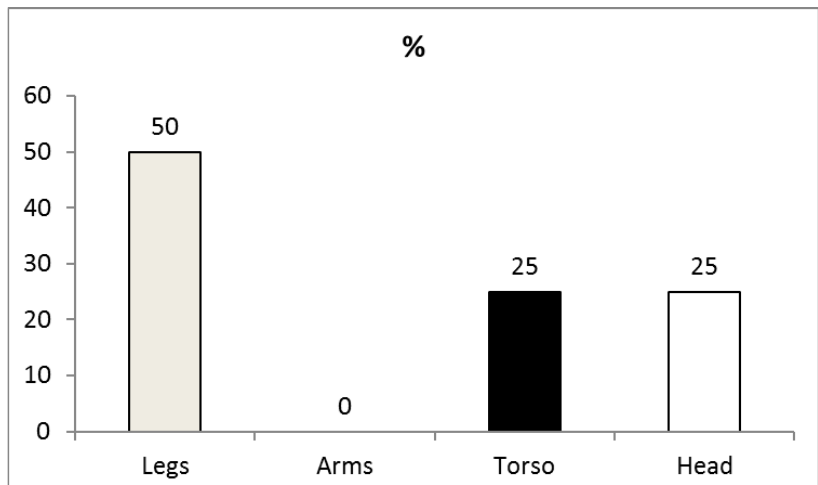
Figure 8. The percentage of injuries depending on the location of the